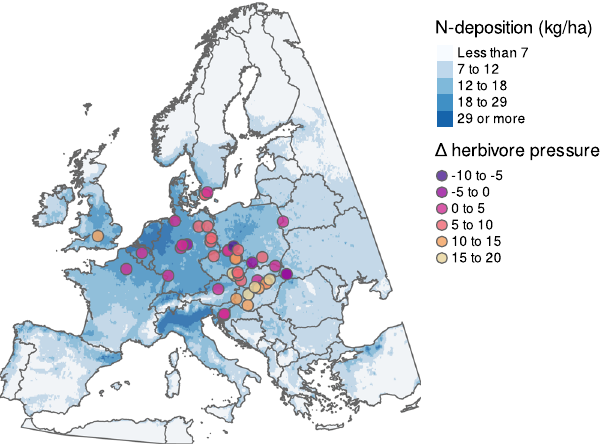
Fig.1|Spatialdistributionofresurveysites,N-depositionintheyear2000,and changes in ( Δ ) herbivory pressure across Central Europe. Our analysis spans 52resurveysiteswithinter-censustimespansrangingfrom10to64years(median: 47.5 years). Color of points corresponds to the magnitude of change in site her- bivore pressure between the baseline survey and resurvey (Supplementary Data fi le 1). Total nitrogen deposition (wet and dry, reduced and oxidized) is calculated usingtheEMEPdatabasefortheyear2000anddisplayedacrossacolorgradientof light to dark blue representing lowest to highest values at a spatial resolution of